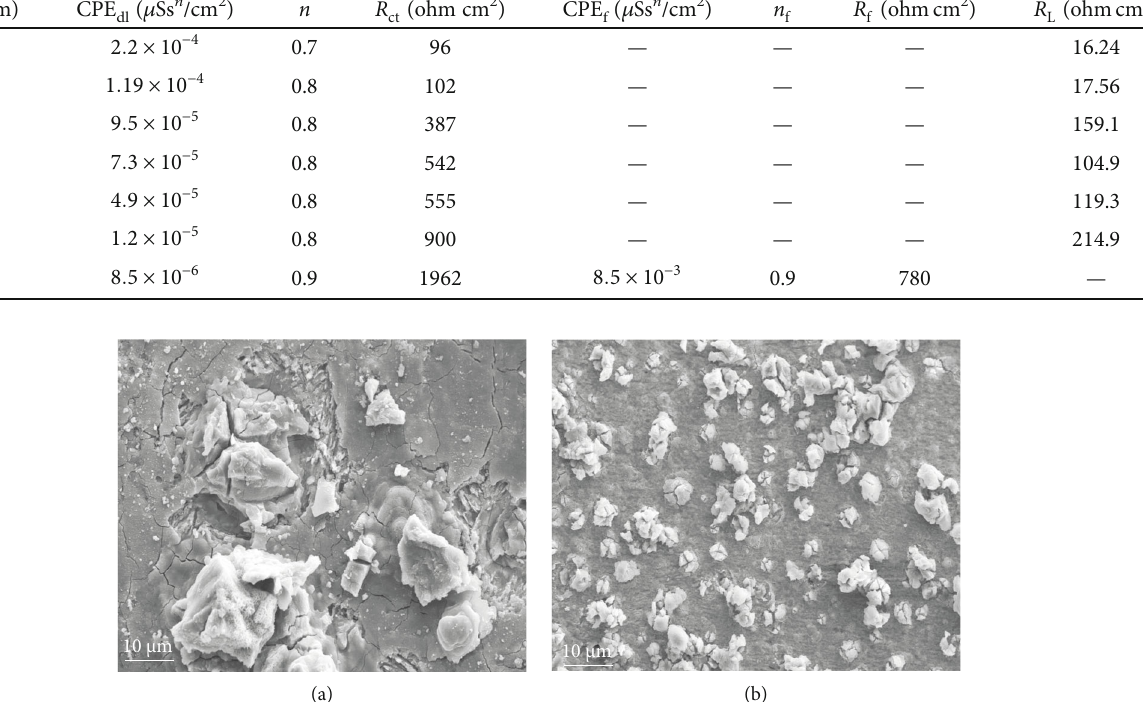
SO in the presence of (a) 0 and (b) 1000ppm of the Sn-metallic 2 4